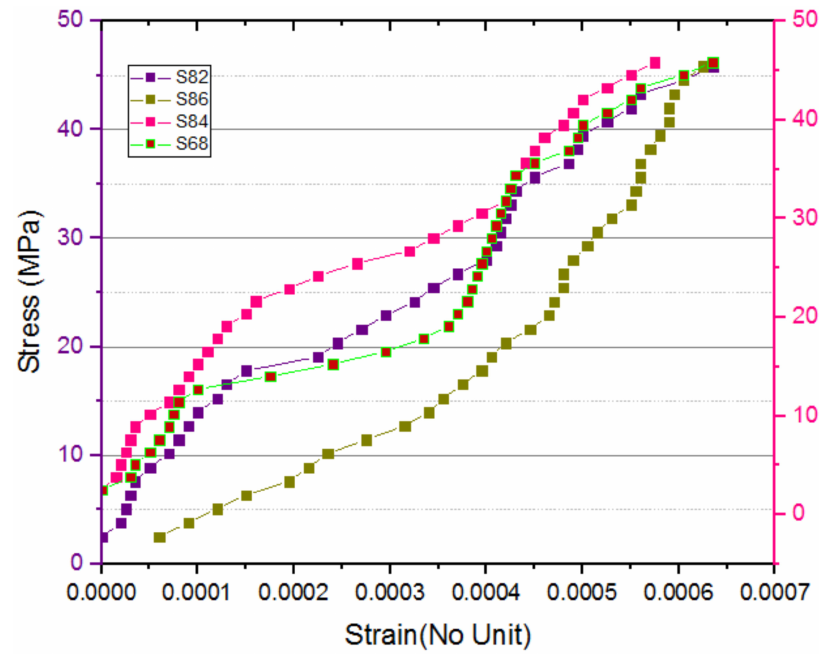
Figure 15. Stress–strain curve for S82 to